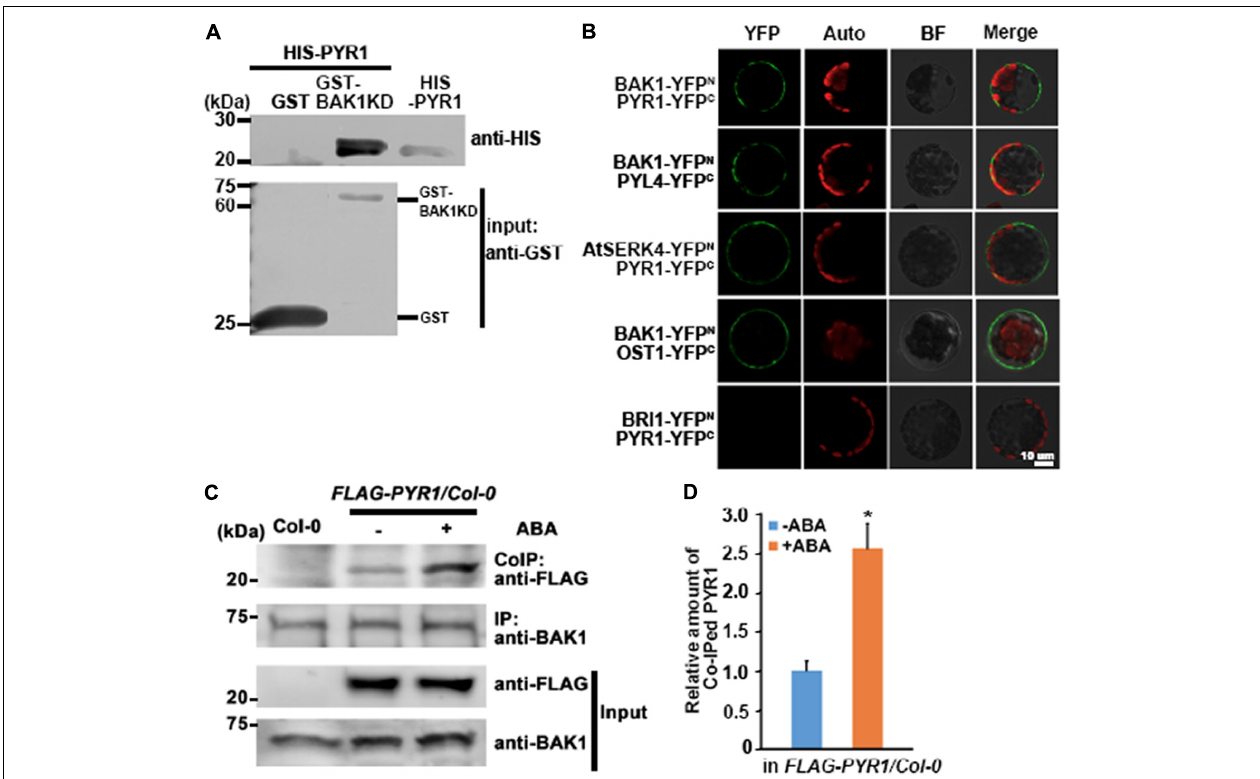
FIGURE 1 | BAK1 interacts with PYR1. (A) BAK1 directly interacts with PYR1 in vitro in a GST pull-down assay. Each of purified GST and GST-tagged BAK1 Kinase Domain (BAK1KD) was incubated with HIS-PYR1. Western blot analyses were performed with anti-GST and anti-HIS antibodies. In upper panel lane 3, 1/20 aliquot of HIS-PYR1 protein was loaded for validation of the HIS-PYR1 detected in lane 2. (B) In vivo interaction between BAK1 and PYR1 or PYL4, and AtSERK4 and PYR1 determined by bimolecular fluorescence complementation (BiFC) analyses. Each pair of constructs was introduced to mesophyll cell protoplasts. Reconstituted fluorescent YFP signals (YFP), auto-fluorescence signals (Auto), bright field images (BF), and merged images (Merge) are shown. Scale bar indicates 10 µ m. (C) ABA induces BAK1 and PYR1 interaction in planta . Using anti-BAK1 antibodies, BAK1 was immunoprecipitated from the protein extracts of transgenic seedlings overexpressing FLAG-tagged PYR1 treated with 30 µ M ABA. Co-immunoprecipitates were identified using anti-FLAG antibodies. (D) Relative amounts of co-immunoprecipitated PYR1 in FLAG-PYR1 expressing transgenic plants in the absence or presence of ABA. Quantification was performed using Image J software from the photograph in (C) and the other two independent experiments as shown in Supplementary Figure 7a (* P < 0.05, compared with samples without ABA).